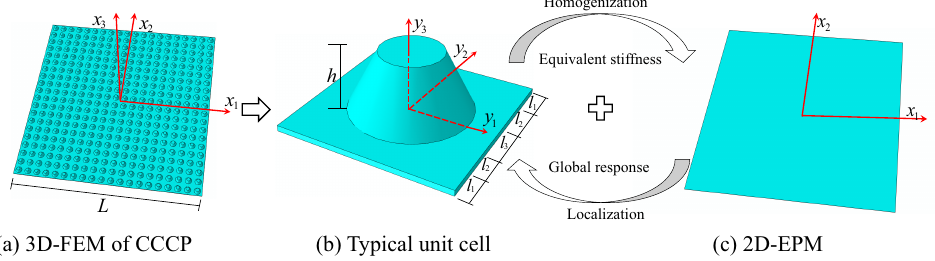
Figure 2. The 3D finite element model (3D-FEM) of the composite conical convex-concave plate (CCCP) ( a ) is divided into a ( b ) 3D unit cell and ( c ) 2D equivalent plate model